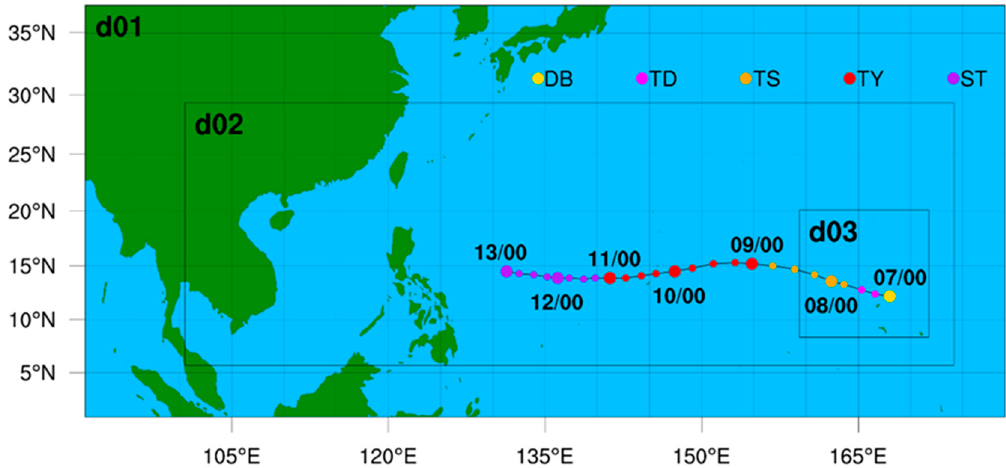
Figure 1. The location of model-simulated domains and the best track of Mangkhut from JTWC during the simulated period from 0000 UTC 7 to 0000 UTC 13 September 2018. Colored dots are the TC track, and colors indicate the categories of TC intensity (DB: disturbance; TD: tropical depression; TS: tropical storm; TY: typhoon; ST: super typhoon).